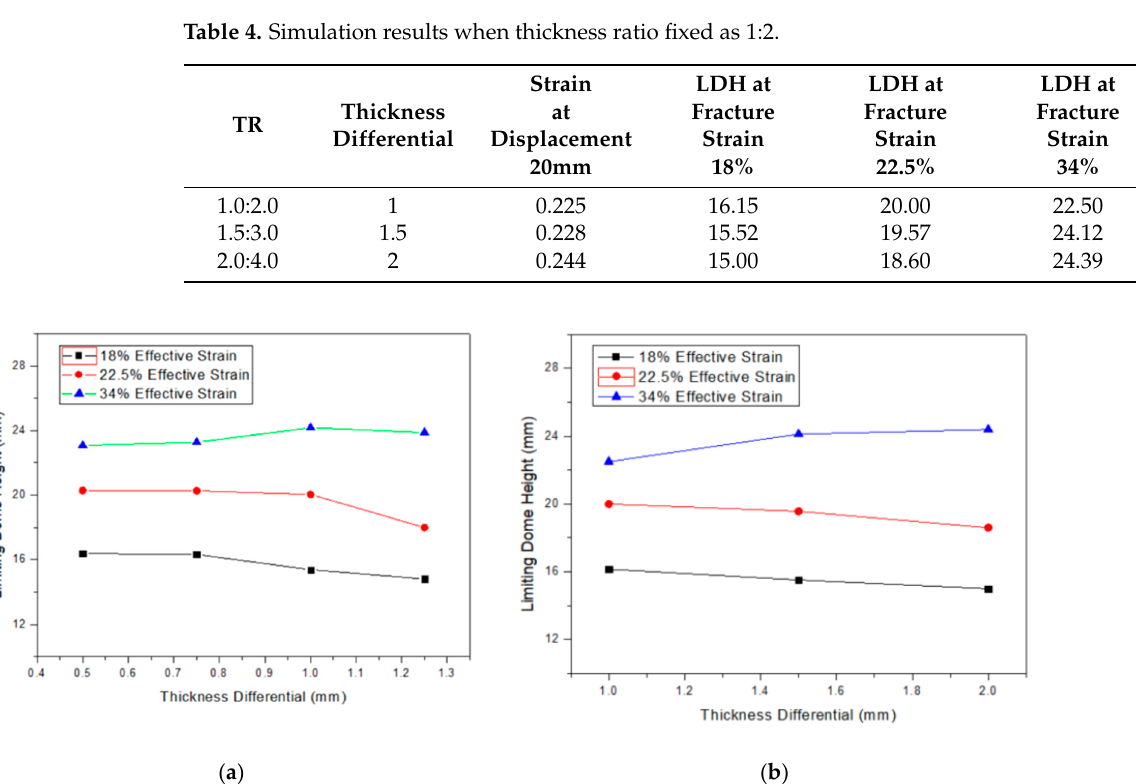
Table 3. Simulation results when thickness ratio fixed as 1:1.5. TR: Thickness Ratios. LDH: Limiting Dome Height.